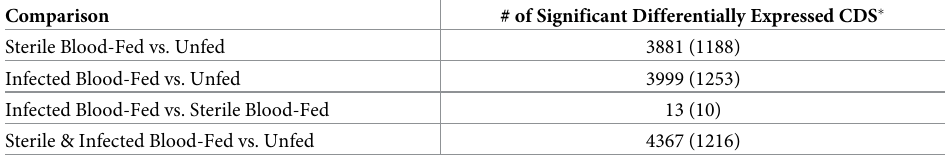
Table 1. Total number of differentially expressed transcripts between the 3 flea treatment conditions based on statistical analysis. Comparison # of Significant Differentially Expressed CDS � Sterile Blood-Fed vs.